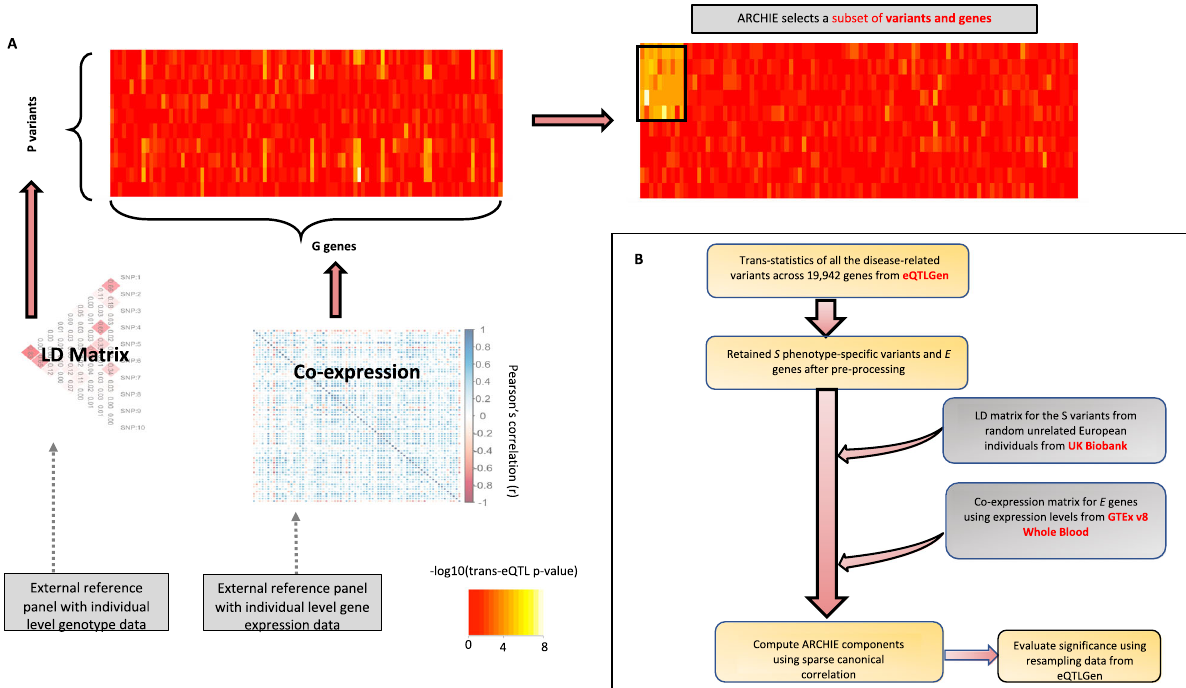
Fig. 1 Overview of ARCHIE and Analysis pipeline. A An illustrative example for ARCHIE. Association statistics ( − log 10 p value) from trans-eQTL mapping for P variants and G genes are shown in the left panel heatmap. Using LD and co-expression estimated from reference datasets, ARCHIE aggregates multiple weaker trans-eQTL associations to select a subset of variants and genes which capture trait speci fi c trans-association patterns (right panel heatmap). B Description of analysis pipeline for summary statistics of trans-eQTL mapping provided by the eQTLGen consortium by integrating external estimates from GTEx (v8) and UK Biobank. See Results and Methods for more details.